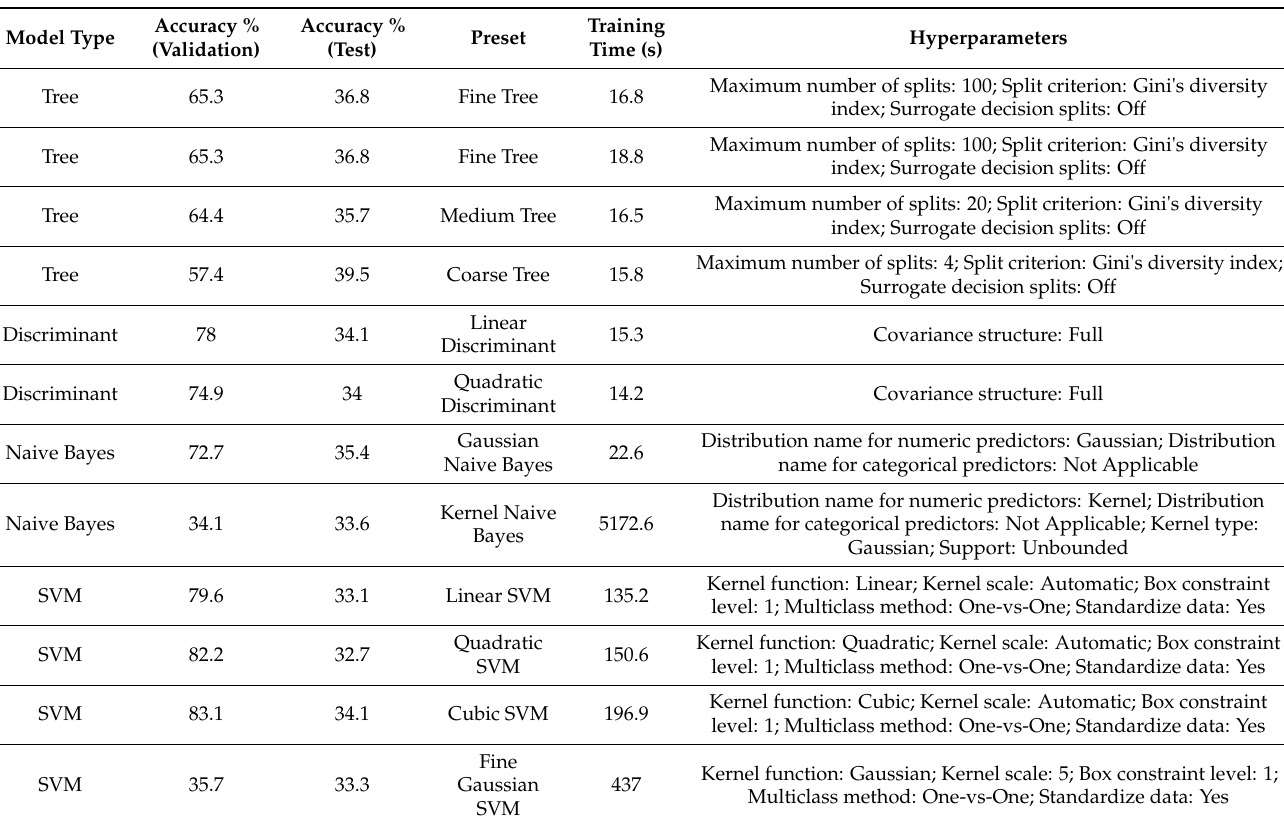
Hyperparameters of experimented presets with 224 × 224 px images;